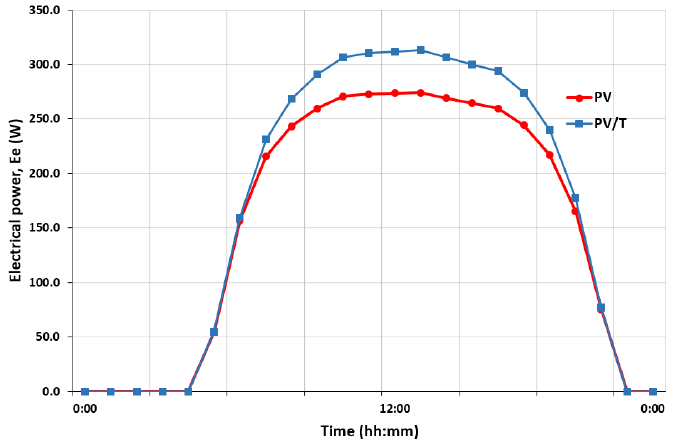
Figure 9. Comparison of PV and PV/T electrical power.